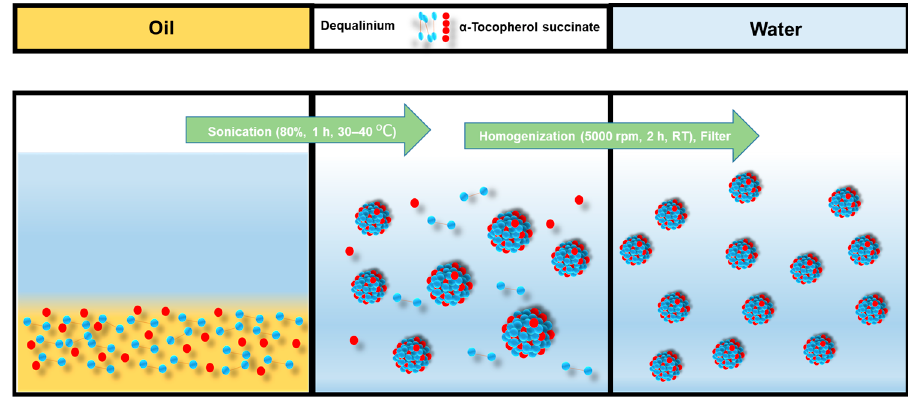
Figure 2. Emulsification process of DTOS emulsion.